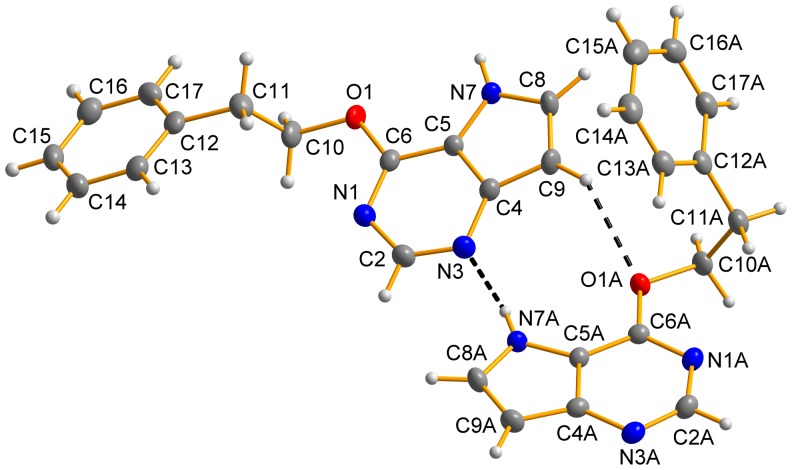
The molecular structure of 6-phenethyloxy-9-deazapurine (HL5), showing the atom numbering scheme and N–H⋅⋅⋅N and C–H⋅⋅⋅O non-covalent bonding (dashed lines).Non-hydrogen atoms are displayed as ellipsoids at the 50% probability level.